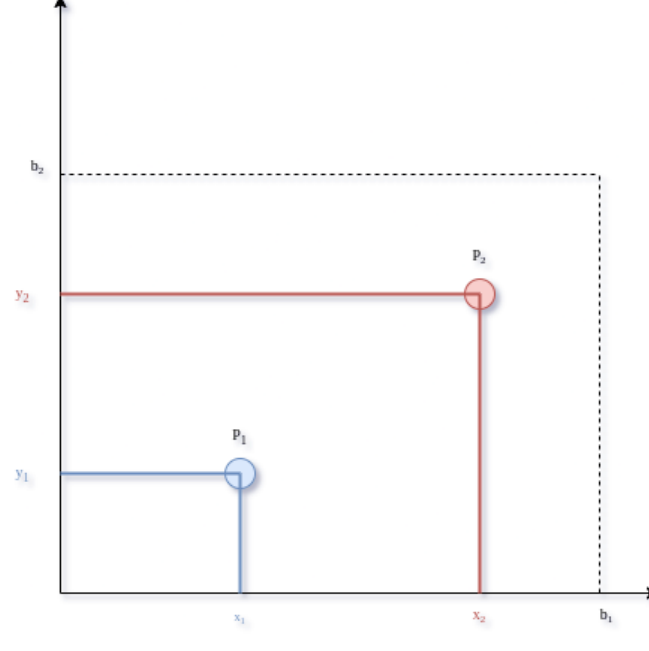
Figure 3. Two-dimensional opposition.